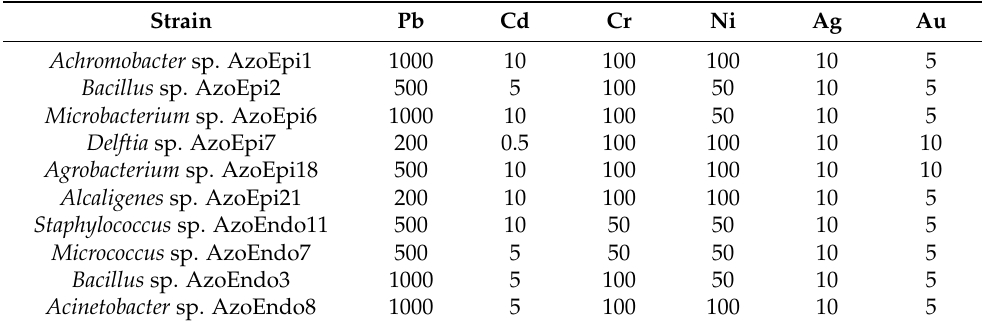
Table 2. MIC for each treatment.